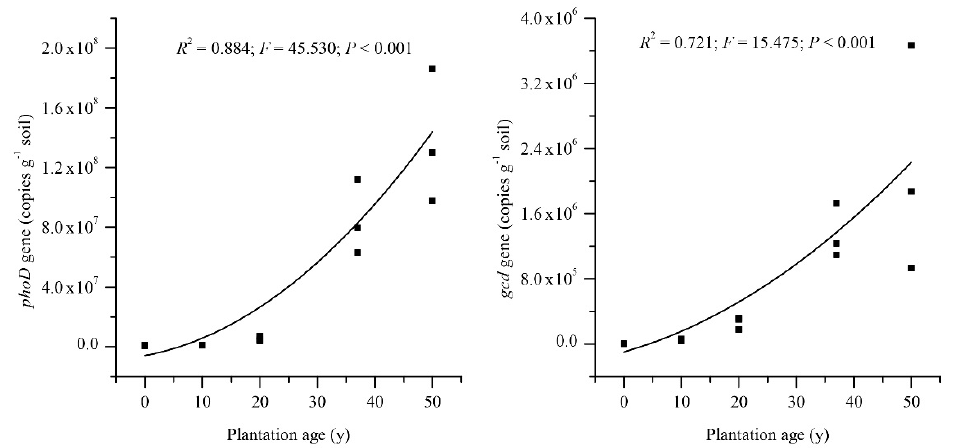
Figure 4. Abundance of phoD and gcd genes and plantation age (y).